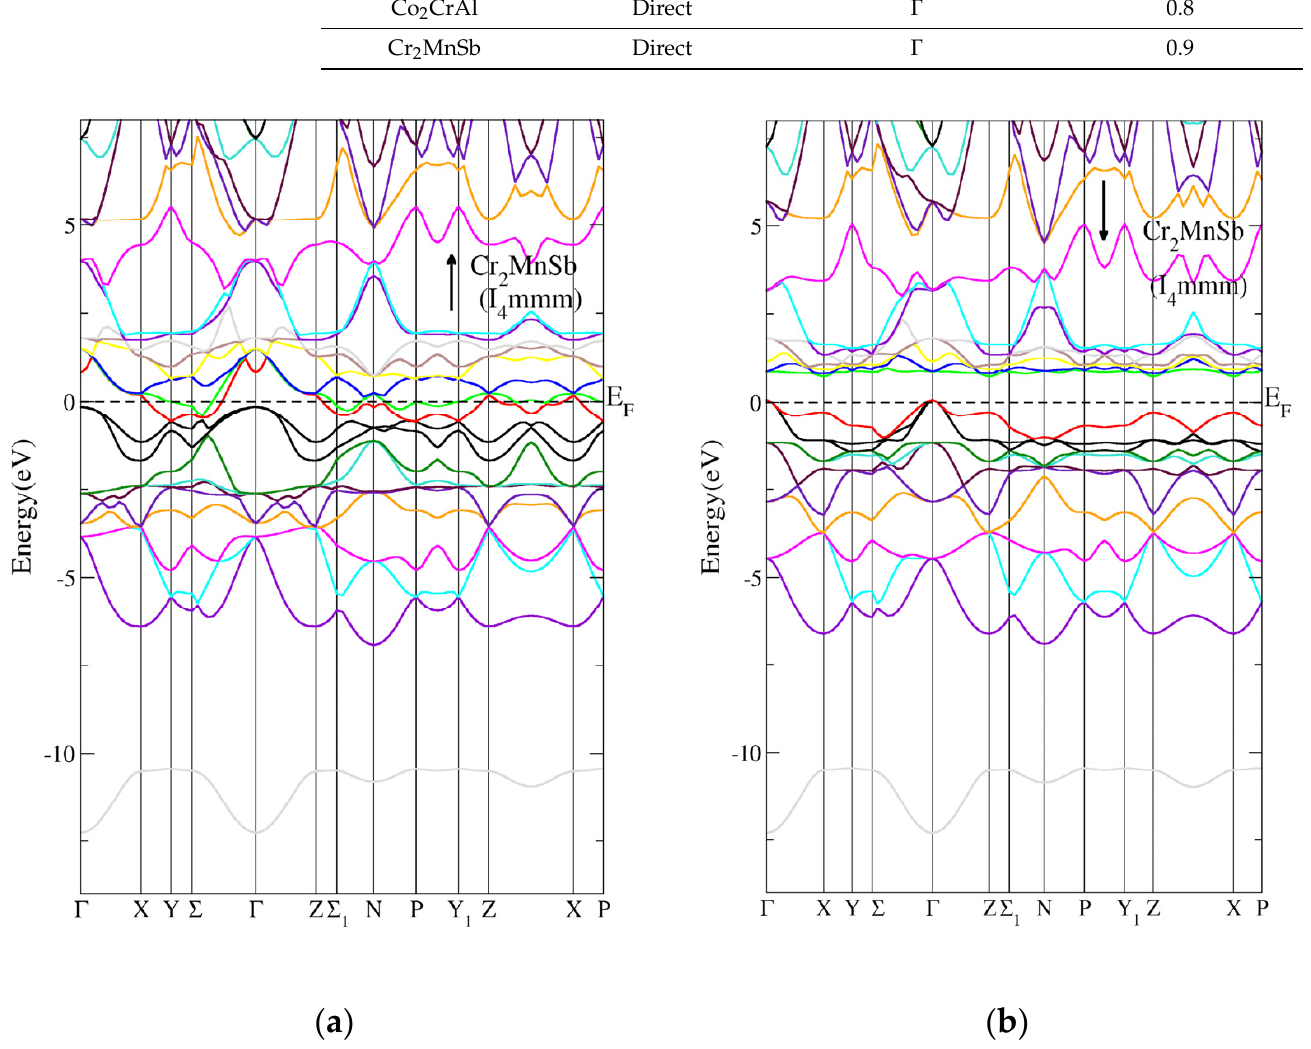
MnSb compound in Figure 13. The band structure for the tetragonal I4/mmm (139) Heusler Cr Figure 13. The band structure for the tetragonal I4/mmm (139) Heusler Cr 2 MnSb compound in (cid:2870) AFM state. ( a ) Spin-up tetragonal I4/mmm Heusler (139) Cr 2 MnSb compound and ( b ) spin-down MnSb compound and ( b ) spin-down AFM state. ( a ) Spin-up tetragonal I4/mmm Heusler (139) Cr (cid:2870) tetragonal I4/mmm Heusler (139) Cr 2 MnSb MnSb compound. tetragonal I4/mmm Heusler (139) Cr (cid:2870)